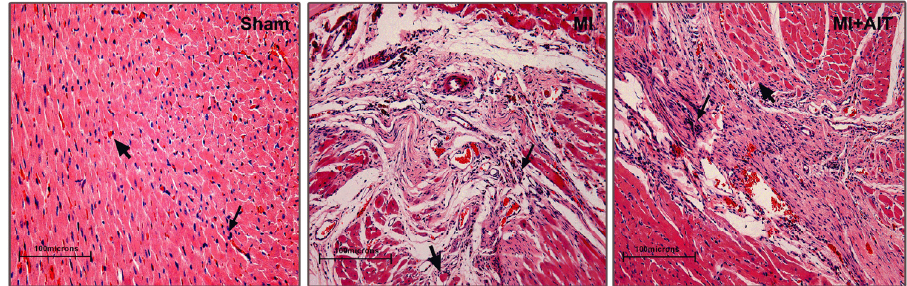
Figure 1. Microstructural changes of left ventricular tissue after MI and AIT intervention. After 8 weeks, the rats were killed, and left ventricular tissue microstructure was determined with HE. indicates nuclei (blue); indicates cytoplasm (pink). Sham: sham-operation; MI: myocardial infarction; MI + AIT: myocardial infarcted rats subjected to aerobic interval training. Bar: 100 μ m. n = 6 per group.